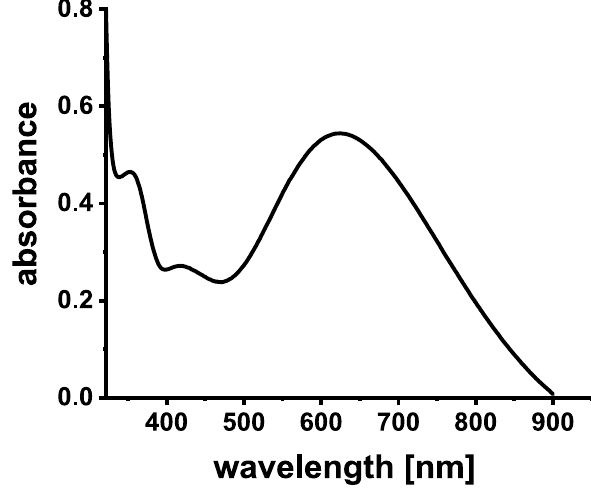
Fig. 8 UV–Vis absorption spectrum of tiron-coated FePt